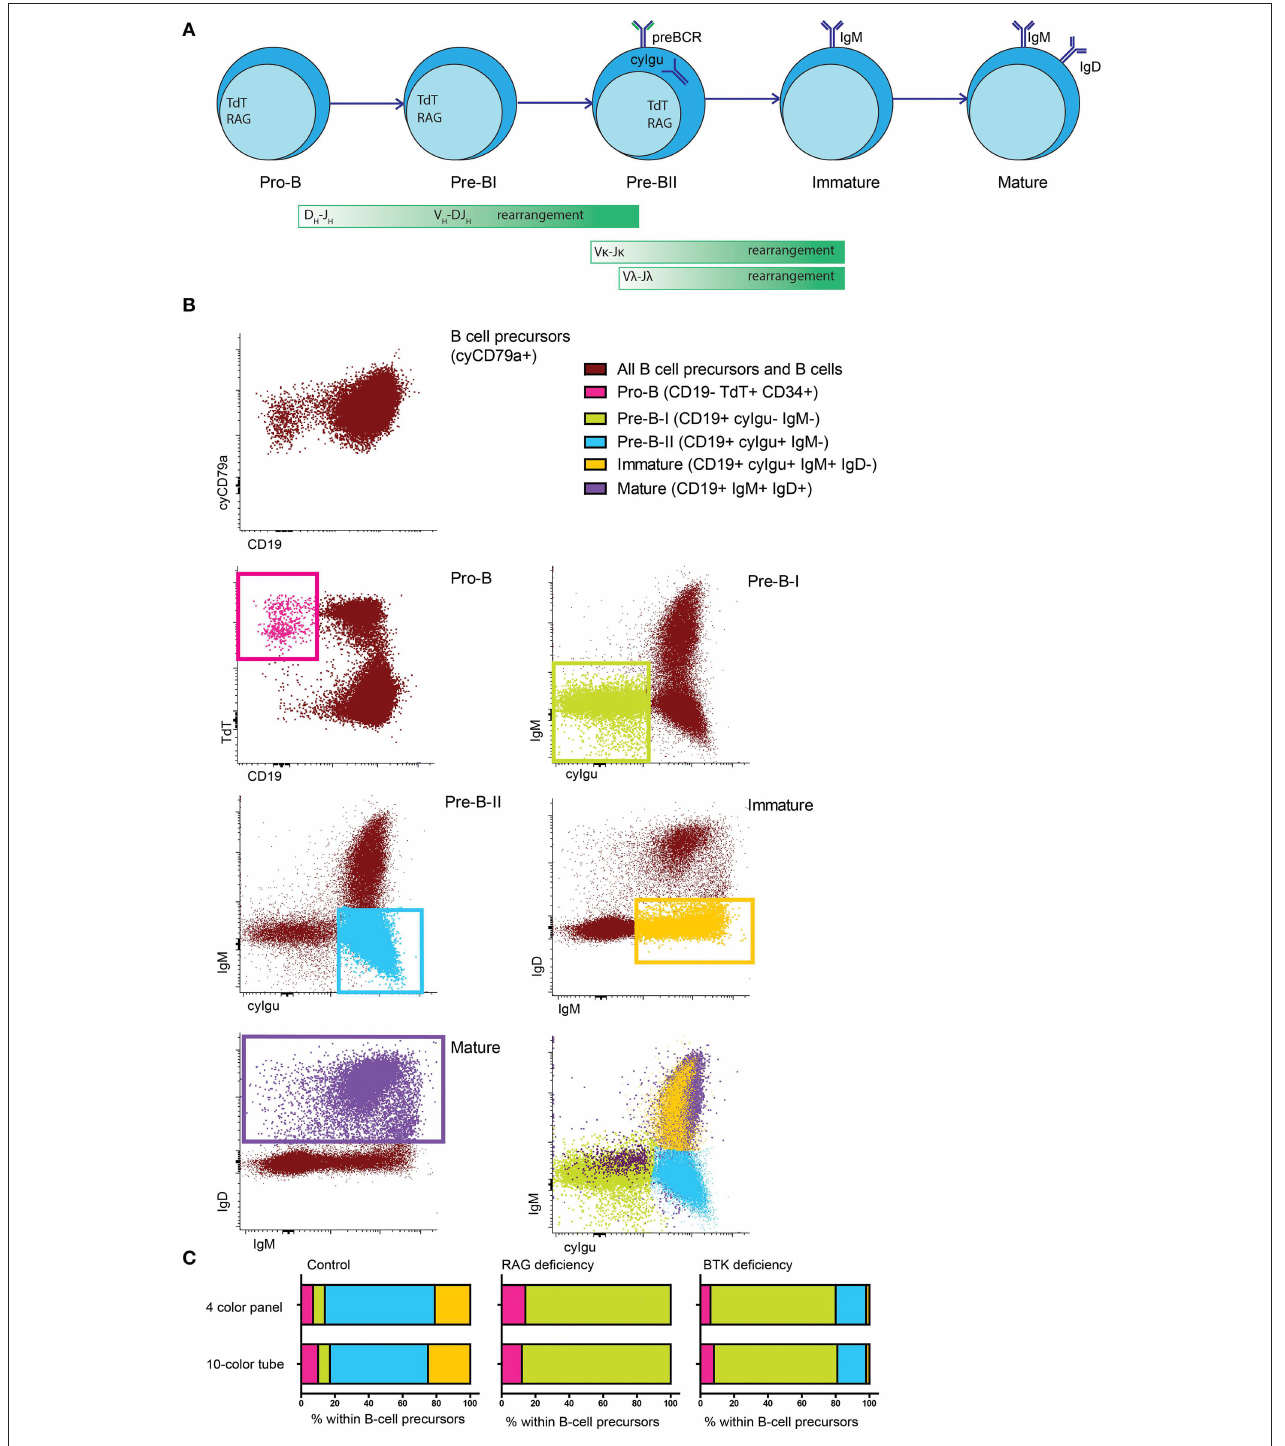
FIGURE 1 | Major BCP subsets in human bone marrow. (A) Schematic representation of the BCP subsets in human bone marrow, the green bars indicate when recombination processes take place. (B) Population definition based on BCR-related markers. All cyCD79a expressing cells are considered BCP or B cells. Pro-B cells are defined as CD19- TdT + , pre-BI cells are defined as CD19 + cyIg µ - IgM-, pre-BII cells are defined as CD19 + cyIg µ + IgM-, immature B cells are defined as CD19 + IgM + IgD- and mature B cells are defined as CD19 + IgM + IgD + . (C) BCP subset distribution in the same sample that was acquired in parallel with two different panels. Population definition was in both cases done as indicated